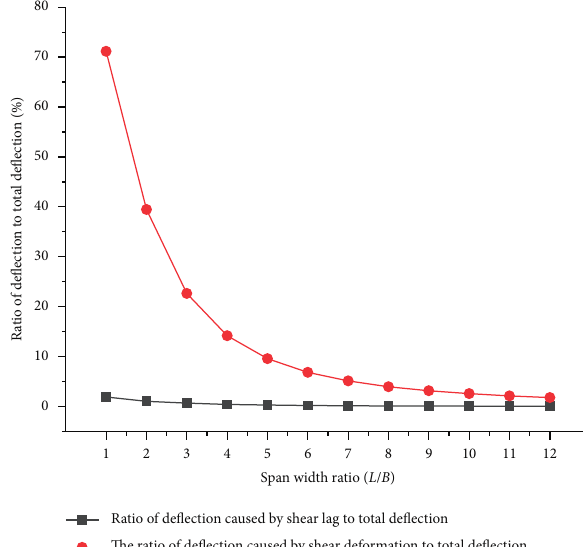
Figure 14: Influence of span width ratio on the deflection of the single box and single cell box girder under concentrated load condition.